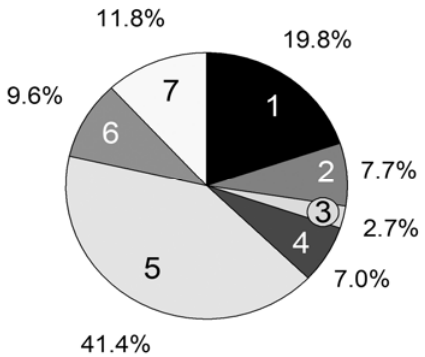
and p ; 2: Reaction choice; 3: v v